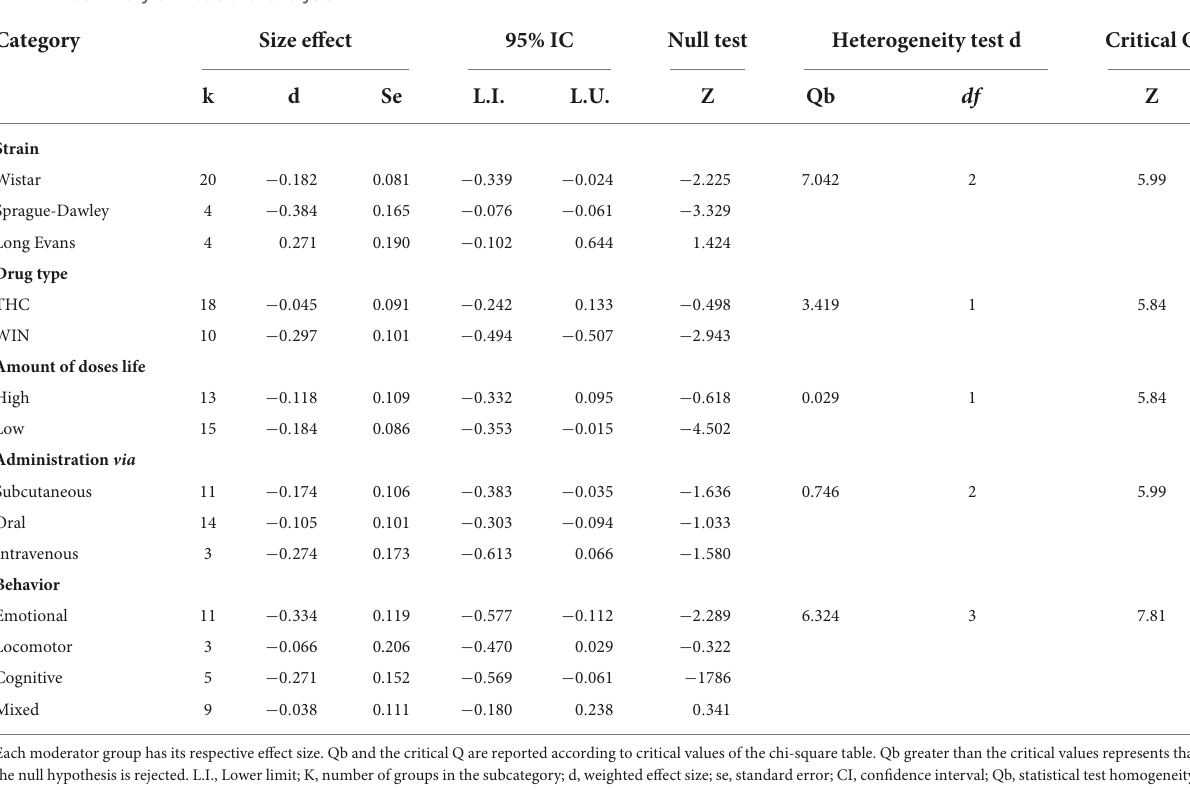
TABLE 2 Summary of moderator analysis.